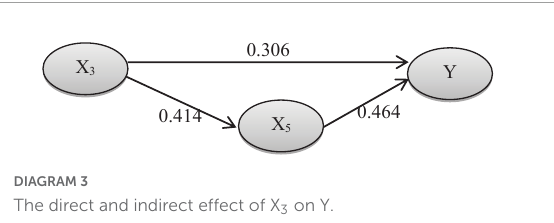
DIAGRAM1 The direct and indirect effect of X 1 on Y.